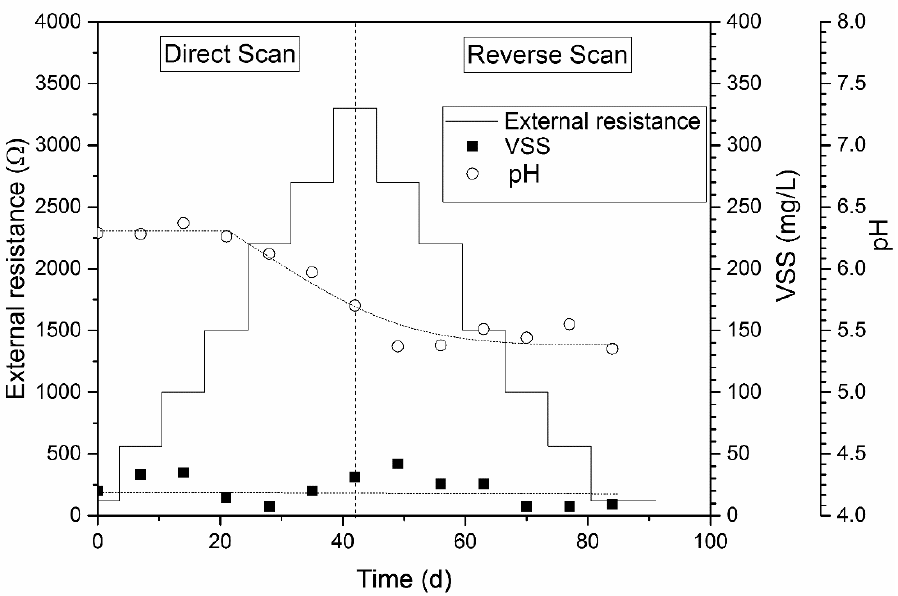
Figure 5. Volatile suspended solids’ concentration and pH of effluent at every external resistance.